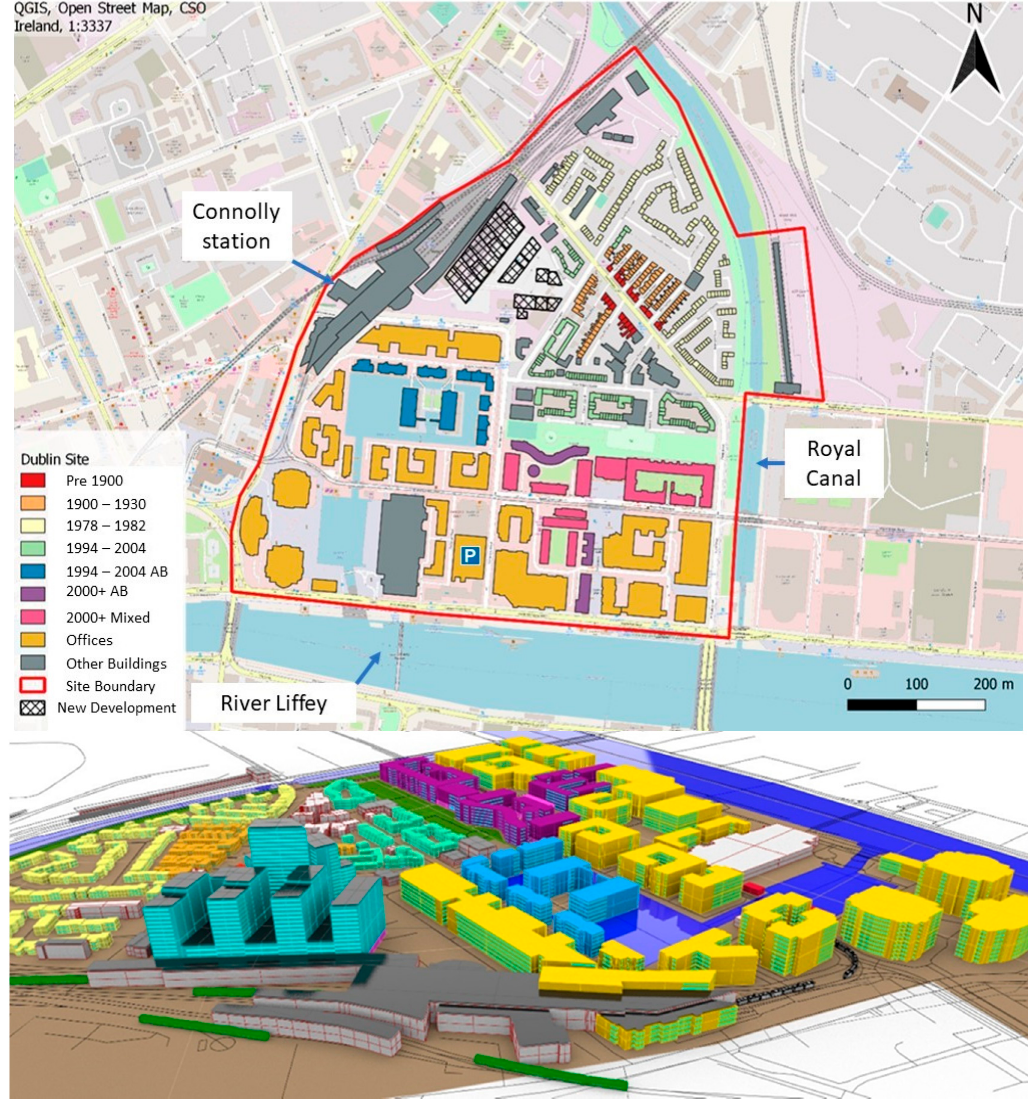
Figure 1. A map and 3D rendering of the neighbourhood study area. Building Energy Ratings (BERs; generated as part of an energy performance certificate (EPC)) are required of every dwelling sold or rented since 2008; the BER grade is based on an evaluation of the dwelling following an inspection that generates an EUI (kWhm − 2